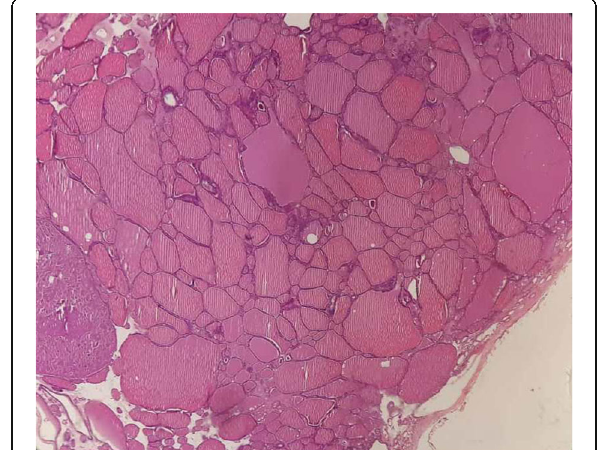
Fig. 2 Post-contrast-computed tomography image. Axial view showing a homogeneously enhancing thyroid gland Fig. 3 Thyroid nodule consisting of macro vesicles (×